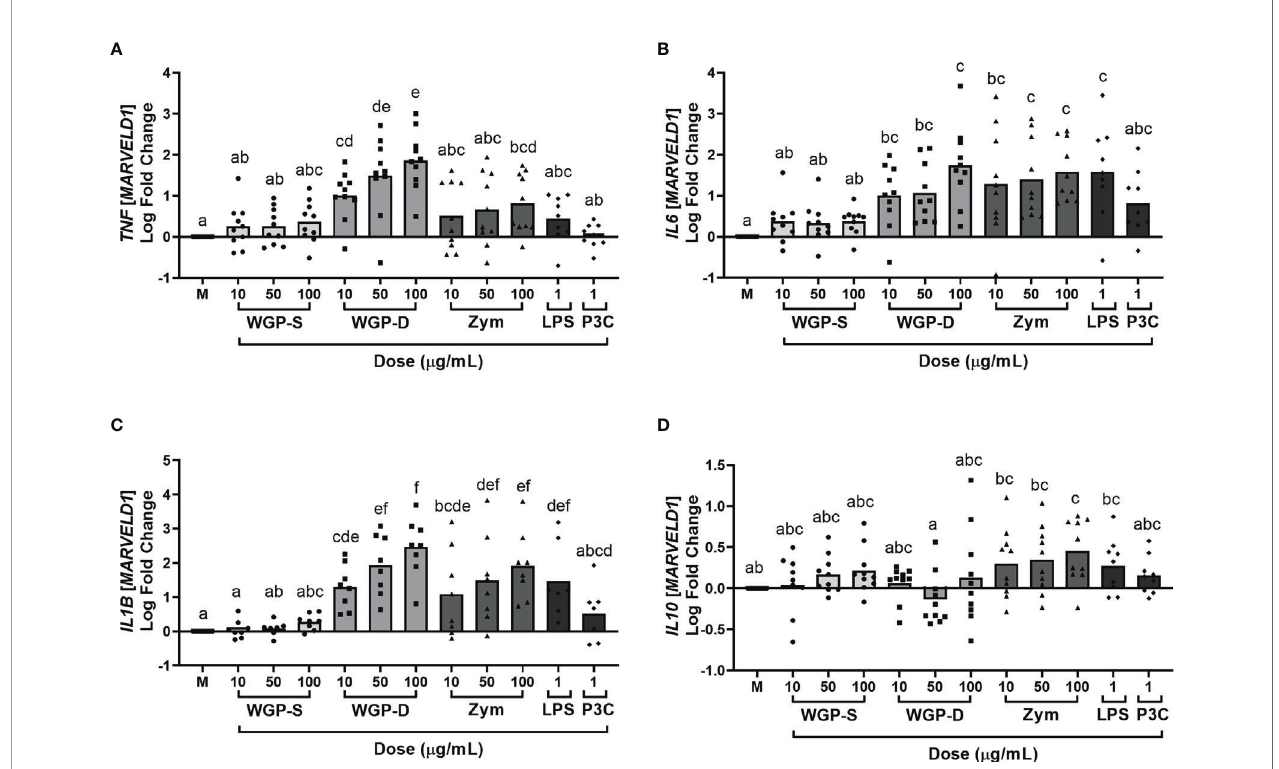
FIGURE 2 | Cytokine relative mRNA expression, evaluated by RT-PCR and normalized to the mRNA expression of the reference gene MARVELD1 , in bovine monocytes cultured for 24 h with WGP Soluble (WGP-S), WGP Dispersible (WGP-D), Zymosan (Zym), LPS, and Pam3csk4 (P3C). Data are presented as Log fold change relative to medium (M) and represent means of ten animals for TNF (A) , IL6 (B) , and IL10 (D) , and eight animals for IL1B (C) . Each symbol corresponds to a different animal. a,b,c,d,e,f Means with different superscript letters are signi fi cantly different ( P